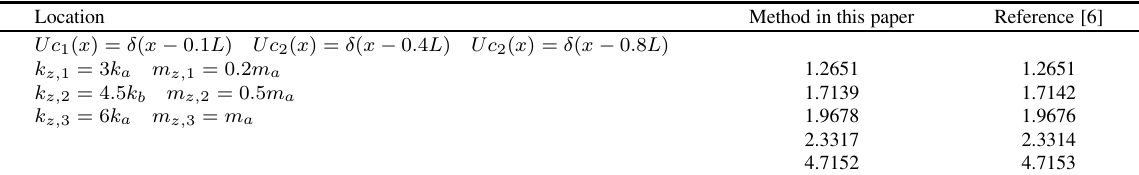
Table 2 The natural frequency coefficients β i for a cantilever beam carrying three spring-mass systems Location Method in this